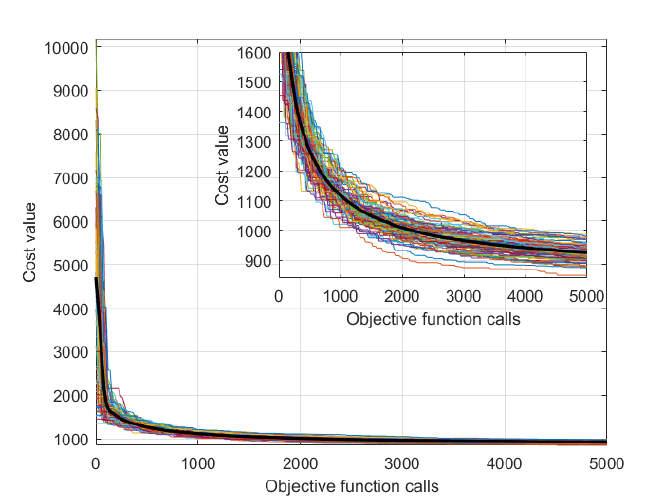
Figure 9. Convergence curves of SNO on 100 independent